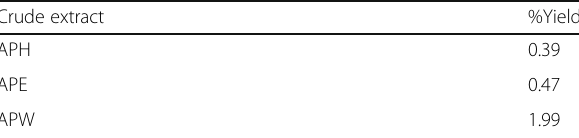
Table 2 Percent relative inhibition and half-maximal inhibition concentration (IC 50 ) on HIV-1 PR activity of AP crude extracts,